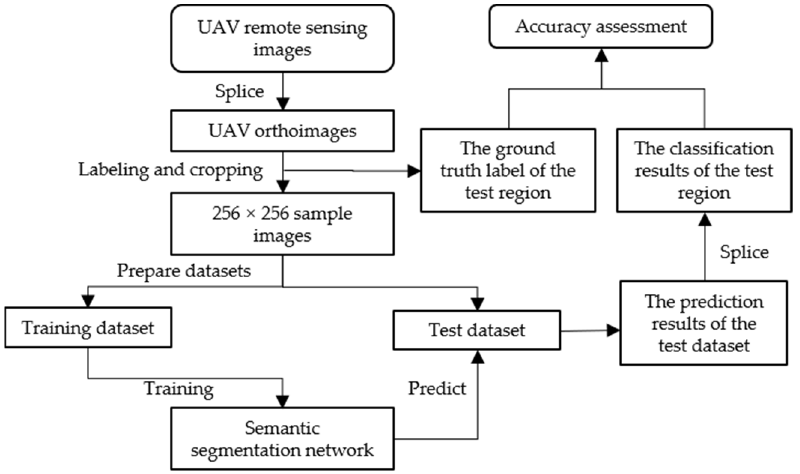
Figure 1. Flowchart of intercropping recognition by improved OCRNet using UAV visible images .